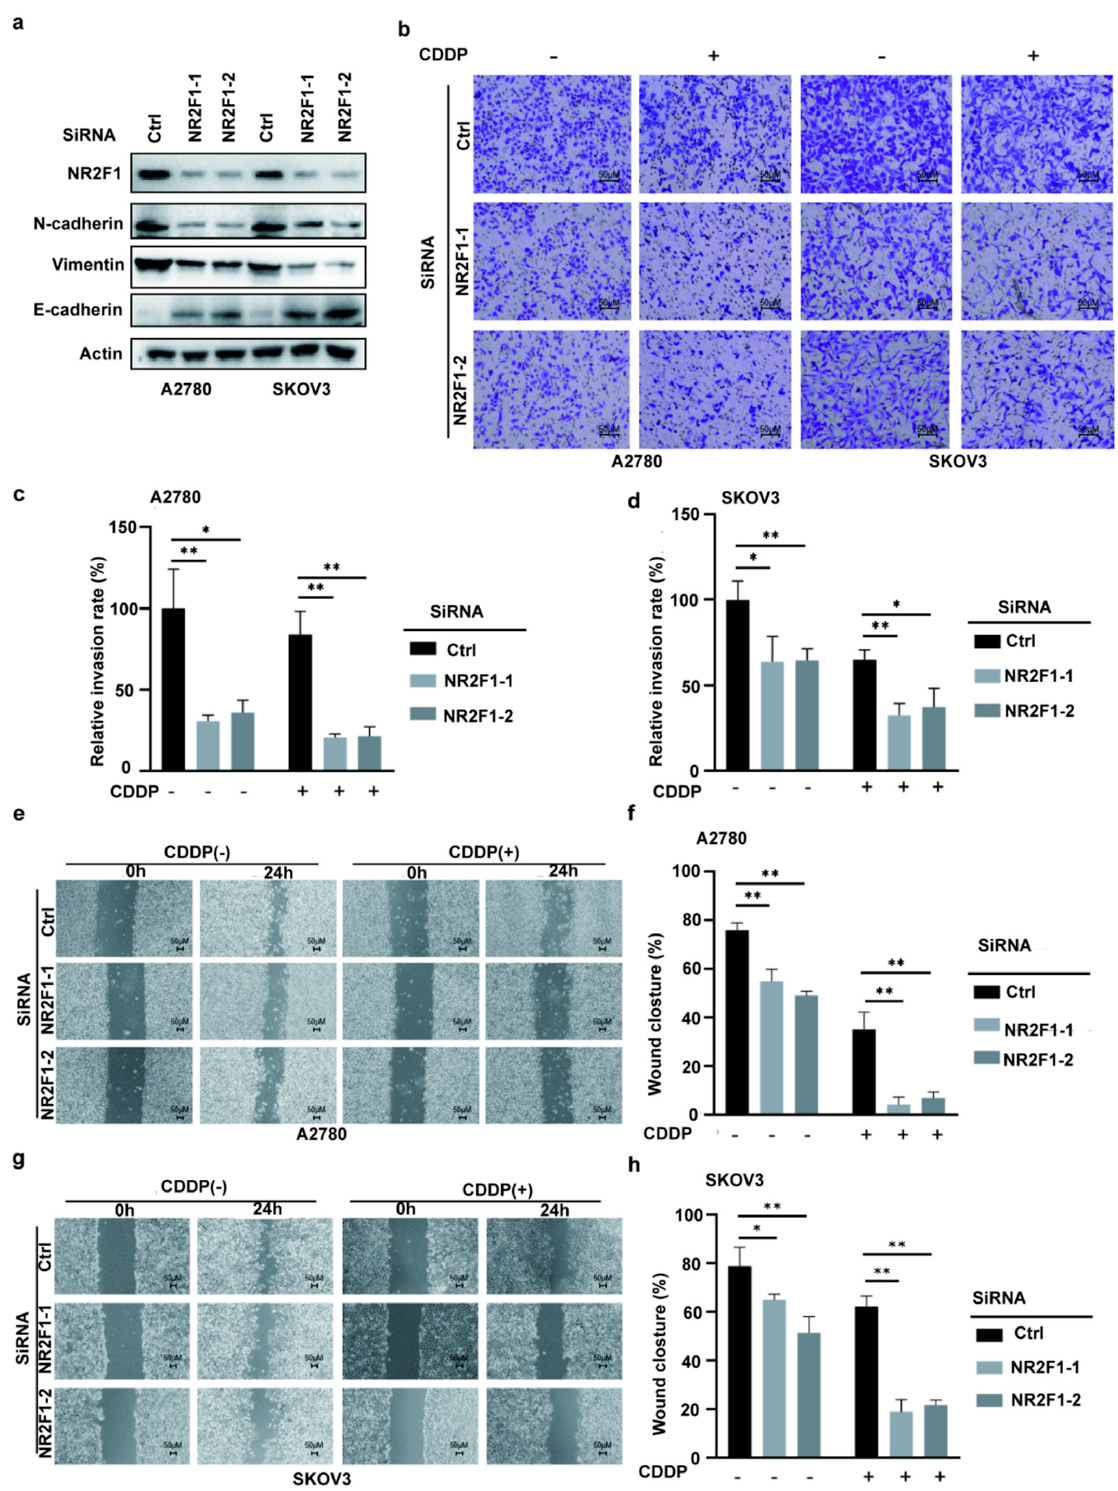
Figure 5. Silencing NR2F1 inhibits EMT. ( a ) Western blot analysis of NR2F1, E-cadherin, N-cadherin and vimentin in siNR2F1-transfected A2780 and SKOV-3 cells. The uncropped blots are shown in File S1. ( b – d ) Examination of the invasiveness of siNR2F1-transfected A2780 and SKOV3 cells without or with cisplatin treatment (20 µ M) using transwell assay. ( e – h ) Examination of the migration of siNR2F1-transfected A2780 and SKOV3 cells without or with cisplatin treatment (20 µ M)